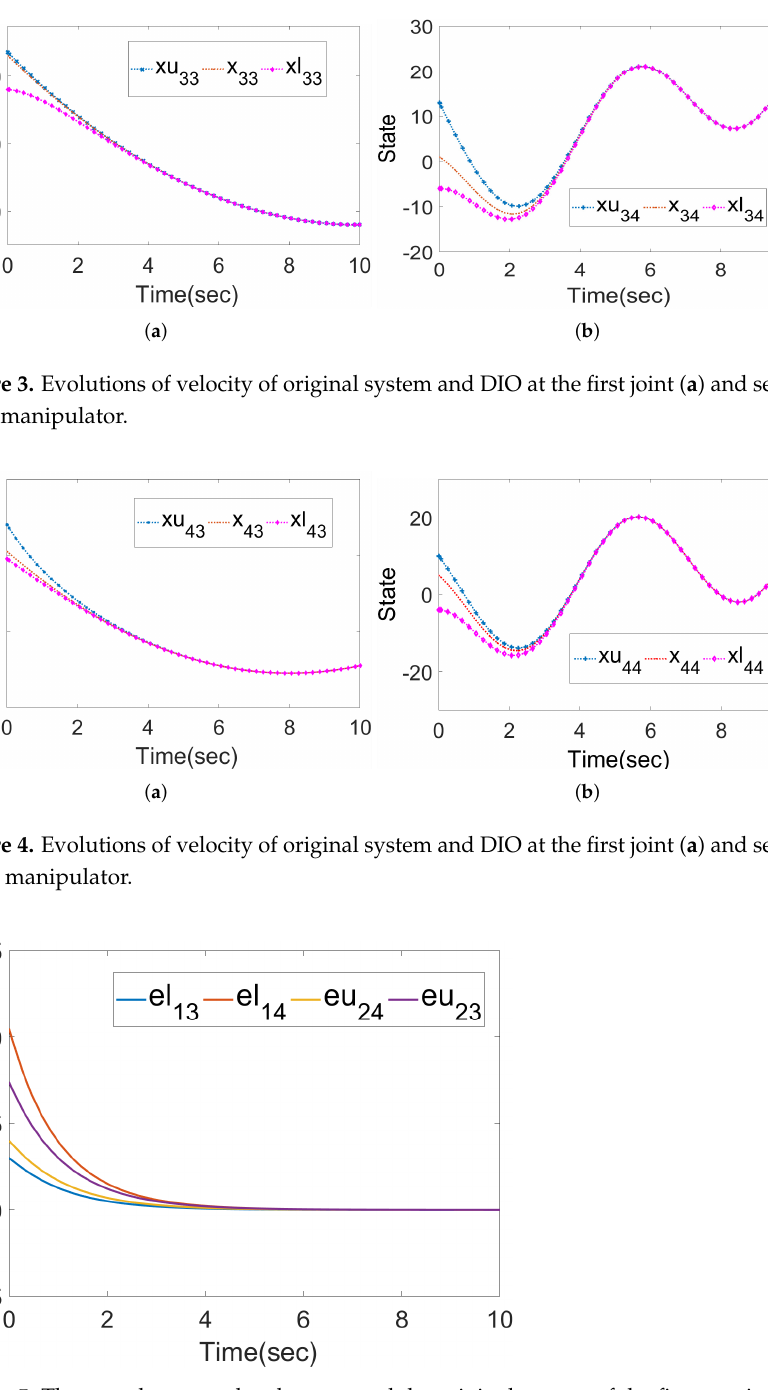
Figure 5. The error between the observer and the original system of the first